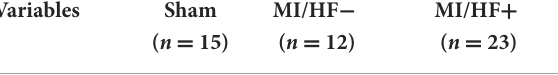
TABLE 1 Assessment of cardiac structure and function using conventional